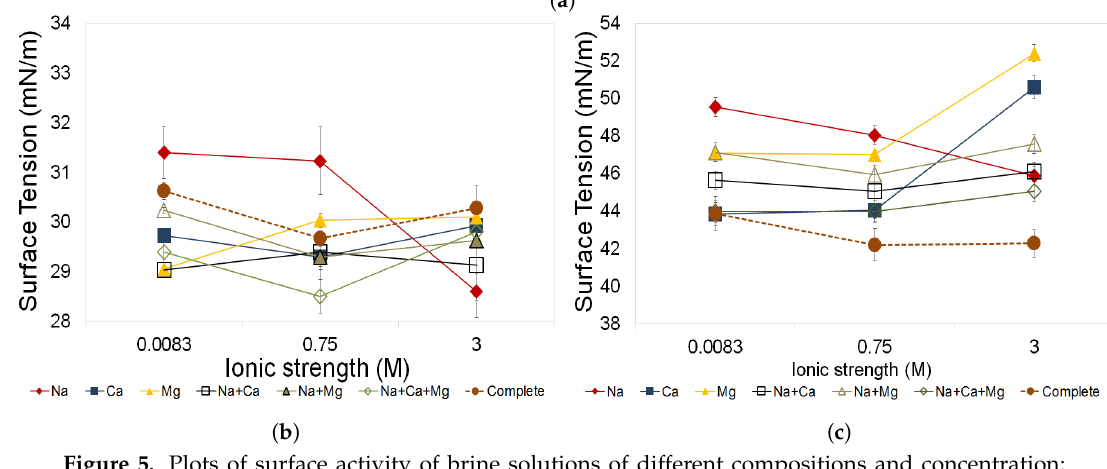
Figure 5. Plots of surface activity of brine solutions of different compositions and concentration: ( a ) without any biosurfactant, the dotted line is the surface tension of water as baseline ( b ) with addition of rhamnolipid ( c ) with addition of Greenzyme. Complete represents brine solution with used at different salinity Na + +Ca 2 + +Mg 2 + +SO 2 − 4